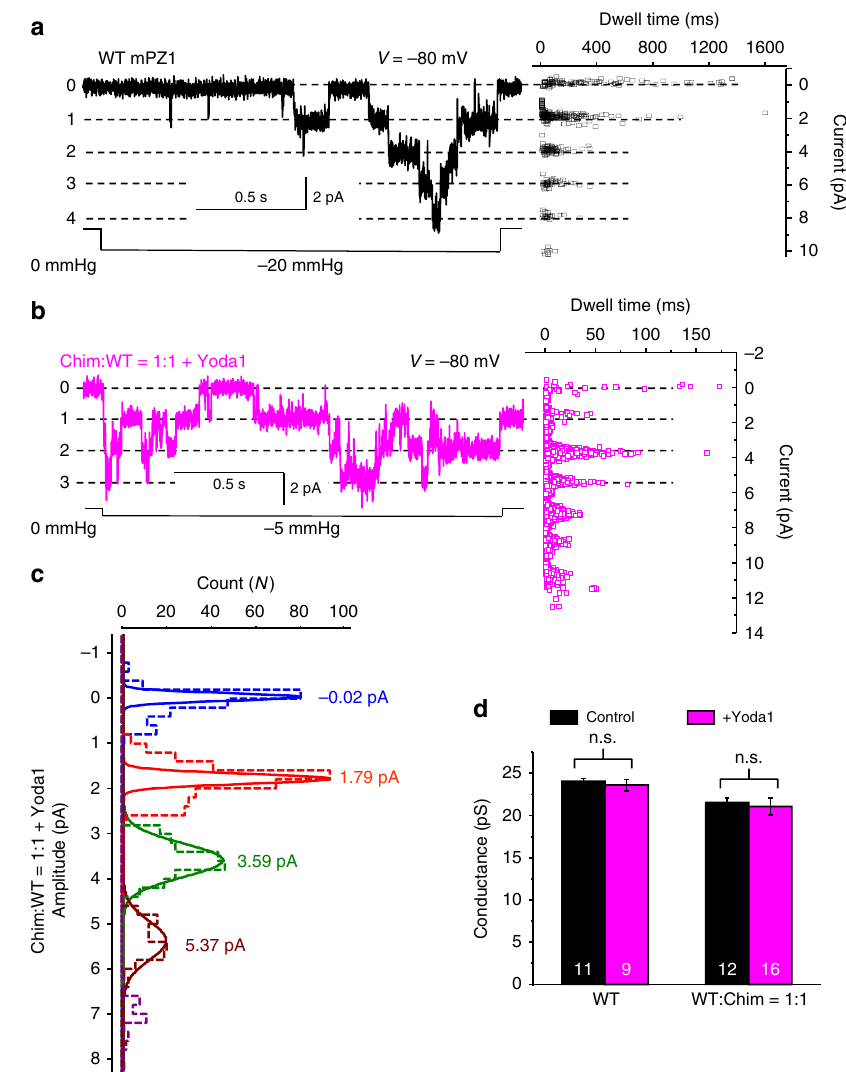
Fig. 8 Yoda1 does not produce long-lived intermediate open states. a Left: example of pressure-evoked single channel currents recorded in cell-attached patches from WT mPZ1 channels at − 80 mV. Right: Plot showing the dwell time vs. current amplitude of detected events. b Same as a for hybrid channels assembled from an equimolar amount of Chim and WT subunits ( V = − 80 mV). c Mean amplitude of single channel currents determined by a Gaussian fi t of the amplitude distribution of single channel currents from cell-attached patches expressing hybrid channels (blue: no open channel, red: one open channel, green: 2 open channels and brown: 3 open channels). d Histograms showing single channel conductance measured at − 80 mV for WT and hybrid channels (Chim:WT = 1:1) in the presence (magenta) or absence (black) of 30 µ M Yoda1. The effect of Yoda1 on single channel conductance was tested using a student t -test. n.s.: non-signi fi cant. In a – c , dwell time and mean amplitude were obtained by averaging at least 20 current traces obtained from at least six independent cell-attached patches. In d , error bars = s.e.m. and the numbers in each bar indicate the number of independent traces